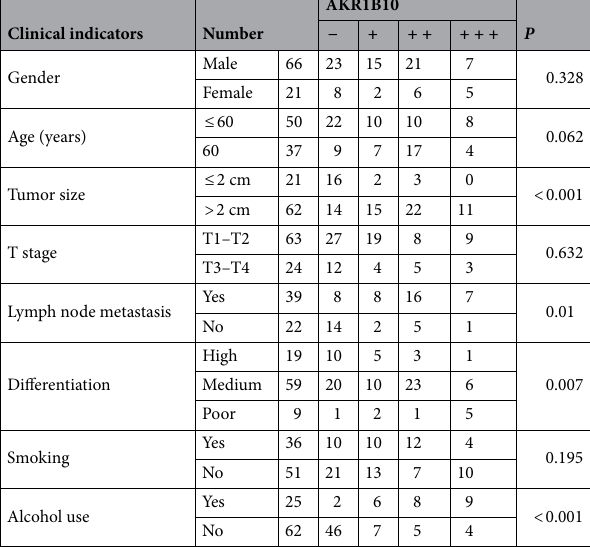
Table 2. Relationships of tumor size, T stage, lymph node metastasis, tumor differentiation, age, gender, smoking status, and alcohol use with AKR1B10 expression in laryngeal carcinoma. + , weakly positive; + + , moderately positive; + + + , strongly positive. All variables were analyzed using Fisher’s exact probability test, excluding age, which was analyzed using the R × C χ 2 test. AKR1B10, aldosterone reductase family 1 member B10.